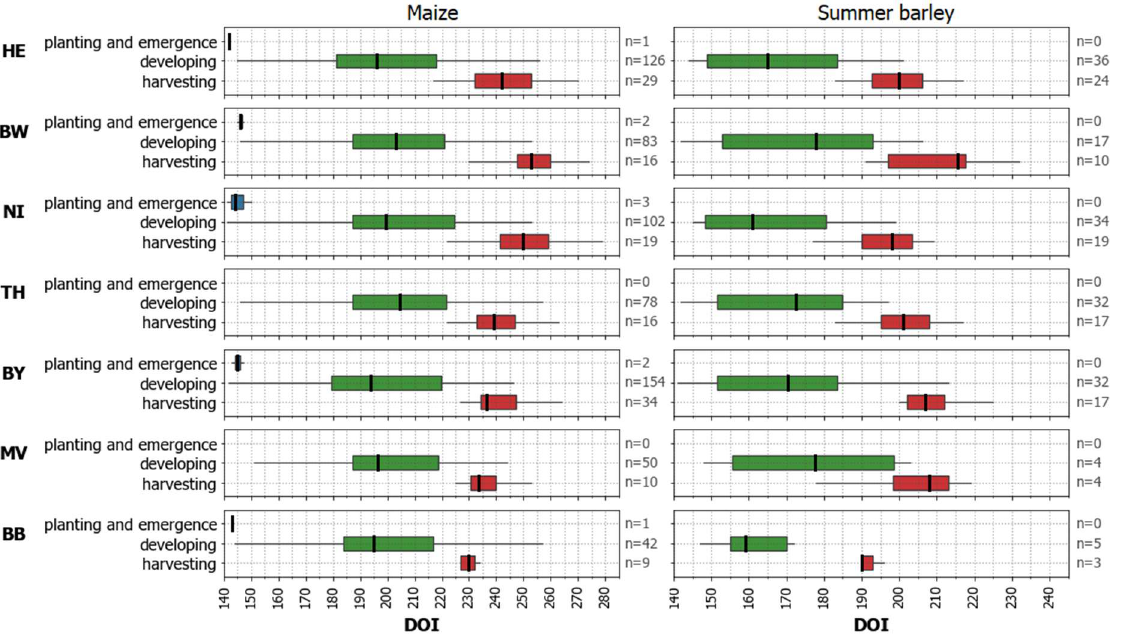
Figure 13. Phenological phase observations for maize and summer barley (part of summer cereals class) located within the seven study sites (data source: DWD, 2018d). The following grouping of recorded phenological phases was applied: ‘Planting and emergence’ include ‘beginning of tilling sowing drilling’ and ‘beginning of emergence’ for maize; ‘Developing’ includes ‘beginning of flowering’, ‘beginning of mil ripeness’, ‘beginning of wax-ripe stage’, ‘yellow ripeness’, ‘tip of tassel visible’, ‘beginning of growth in height’ for maize and ‘beginning of heading’, ‘yellow ripeness’, ‘beginning of shooting’ for summer barley; ‘Harvesting’ includes ‘harvest’ for both classes. No observation was found for the ‘Planting and emergence’ stage for summer barley.